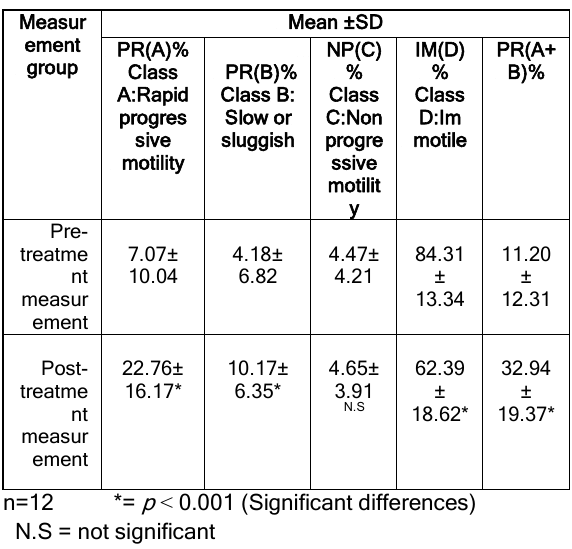
Table 4: The pre-post treatment details and percentages of sperm motility (CASA dynamic parameter analysis report I).